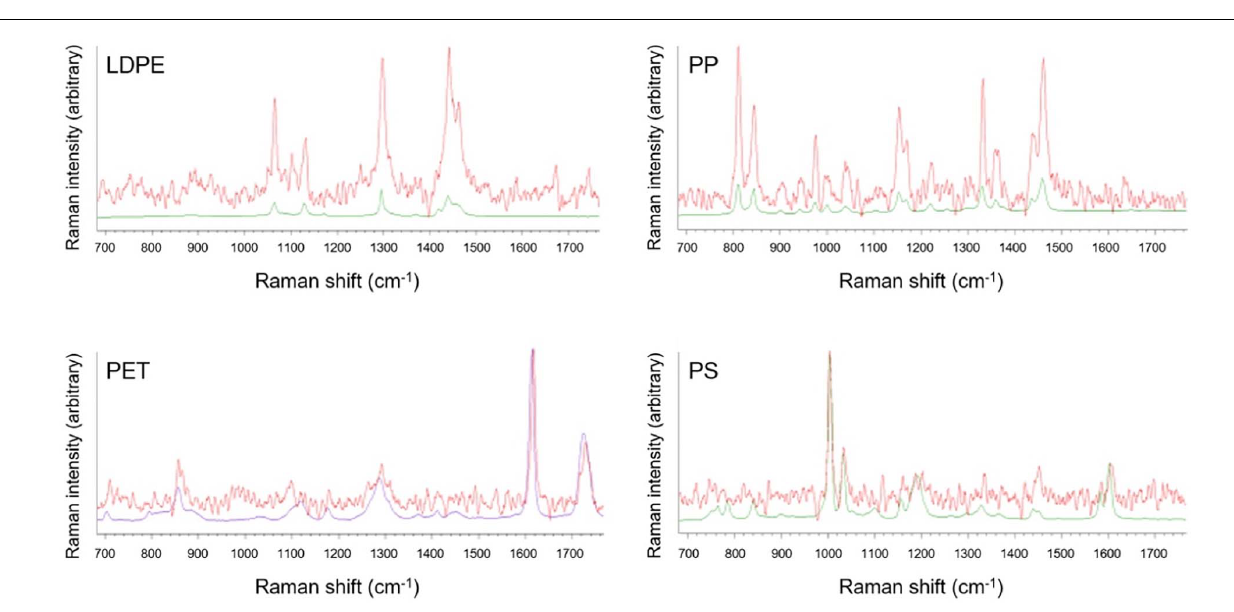
FIGURE 3 | Raman spectra of low-density polyethylene (LDPE), polypropylene (PP), polyethylene terephthalate (PET) and polystyrene (PS), the four most common types of microplastics identified in the sediments of Macao (see Table 4 ). Red lines indicate the Raman spectra of tested samples, while green and blue lines represent the Raman spectra of polymer standards, of which densities are lower and higher than seawater,